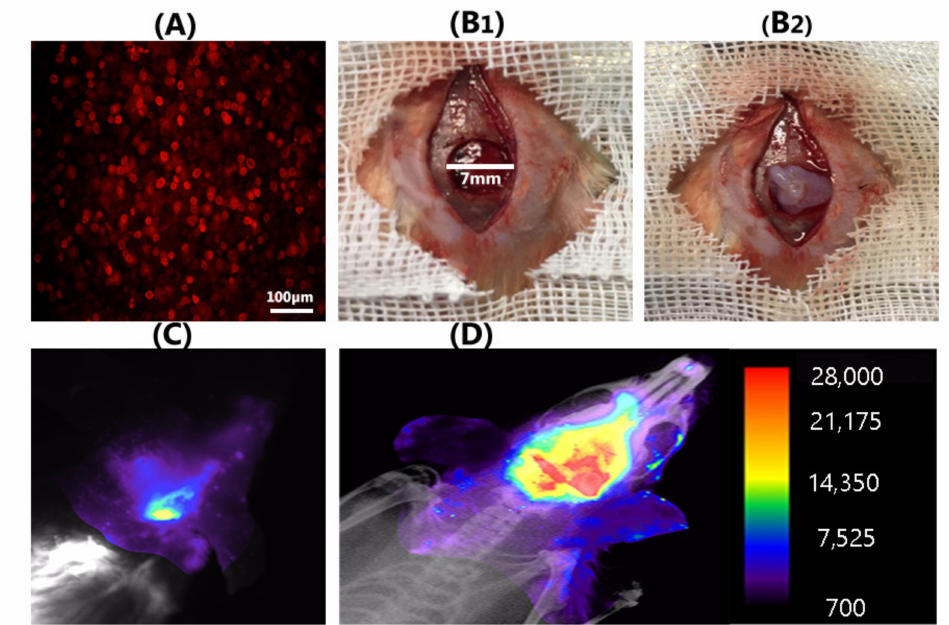
Figure 7. Human OE-MSCs labeled with DiI ( A ); and implanted with collagen hydrogel in a rat calvarial defection with critical size defect (7 mm) ( B1 , B2 ); Representative optical image of blank scaffold group ( C ); and covering images of X-ray and fluorescence images reveal a large number of DiI + OE-MSCs at the calvarial defective region in OE-MSCs group after 72 h ( D ) (scale bar: 100 µ m). 3.8. The Highest Bone Healing Rate of Rat Calvarial Defection Observed in the OE-Mscs